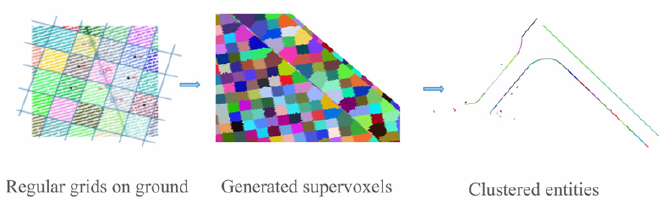
Figure 11. Supervoxels used in [56] for road curb candidate extraction.